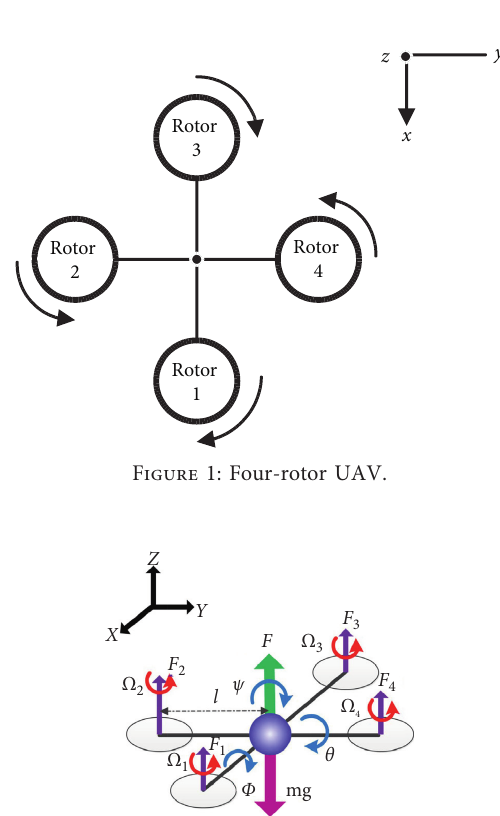
Figure 2: Schematic diagram of a four-wing